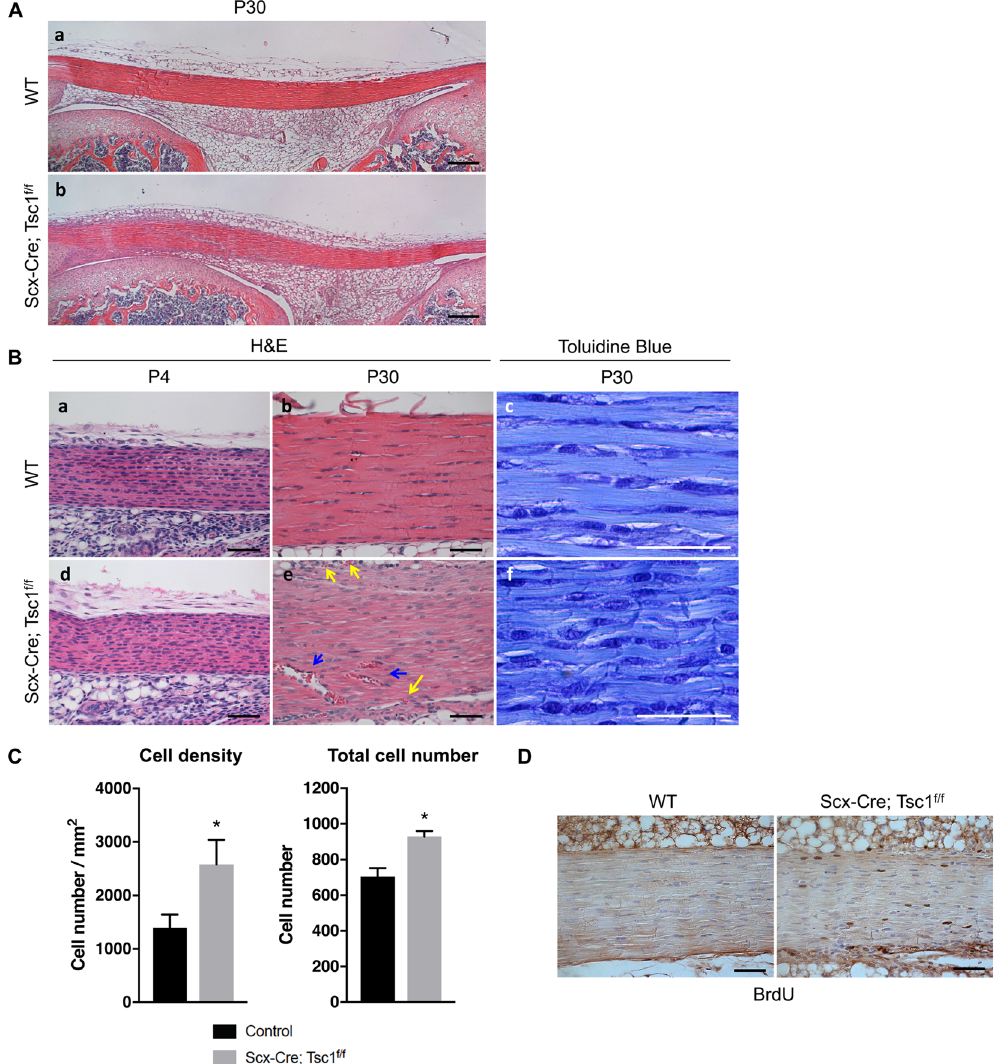
Figure 3. Gain of mTORC1 signaling induces tendon abnormalities. ( A ) Hematoxylin and Eosin (H&E) staining of patellar tendons from wild-type (WT) (a) and Scx-Cre; Tsc1 f/f littermates (b) at P30. Scale bars indicate 200 μ m. ( B ) H&E and toluidine blue-stained sections of patellar tendons from WT (a–c) and Scx- Cre; Tsc1 f/f littermates (d–f) at P4 and P30. Scale bars indicate 50 μ m. Arrows indicate vascularization in the midsubstance (blue arrows), as well as in regions between the patellar tendon and surrounding fat pads (yellow arrows) ( C ) Quantification of cell density and total cell number using toluidine blue-stained sections of patellar tendons (n = 3, * p < 0 . 05 ). ( D ) BrdU staining of patellar tendons from WT and Scx-Cre; Tsc1 f/f littermates at P30. Scale bars indicate 50 μ